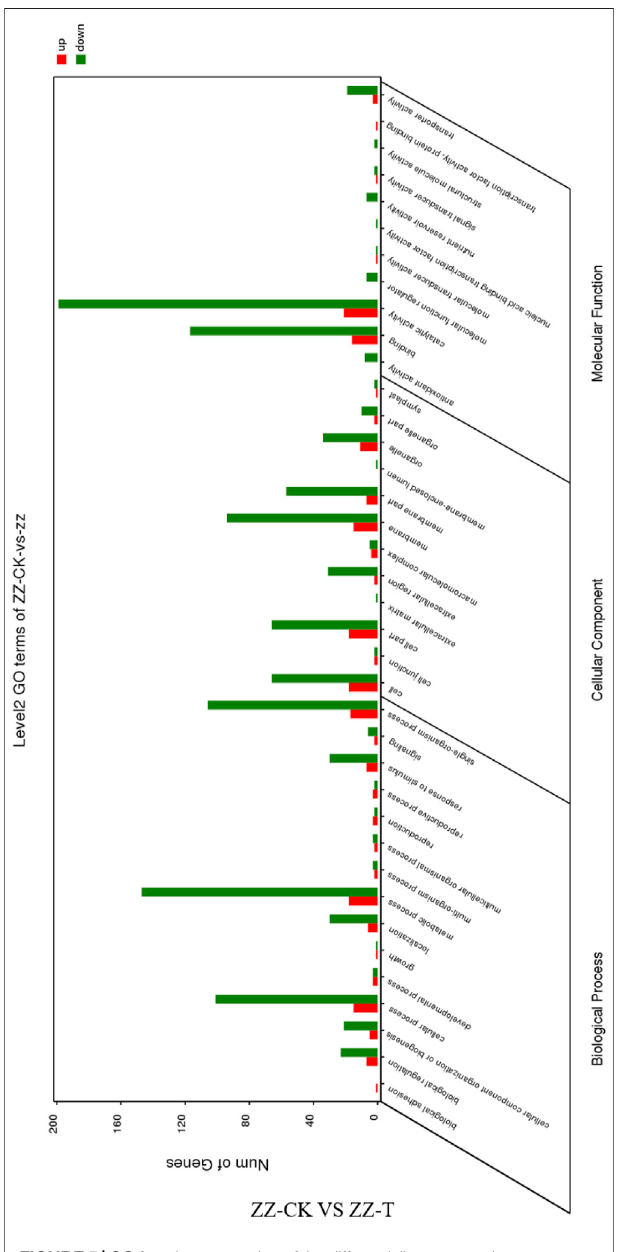
FIGURE 5| GO function annotation ofthe differentially expressed genes in ZZ tea plantation. ZZ, Seeding tea plant. CK: Cutting samples treated with drought for 0 days, T: Cutting samples treated with drought for 20 days.